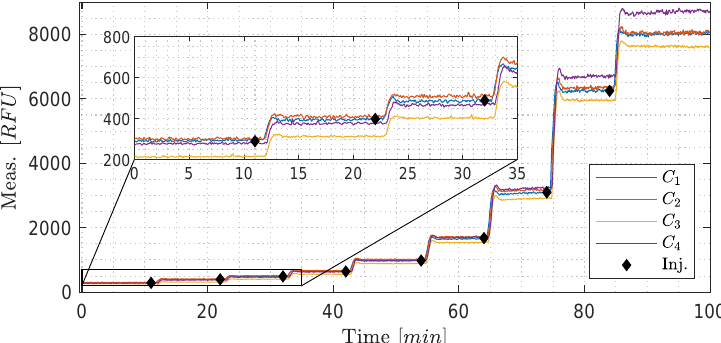
Figure 13. A 100 min experiment with eight different OiW concentrations were added throughout the experiment: 5, 10, 20, 40, 80, 160, 320, and 400 ppm starting at 0 ppm. The injection time is marked with black diamonds. The OiW measurements from the four OiW monitors are displayed in RFU, to evaluate the raw data of the OiW monitor before analyzing the calibration